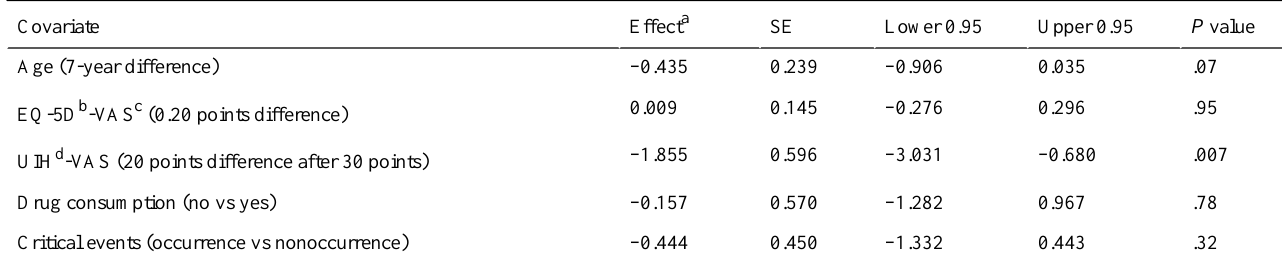
Table 3. Multivariate model for State-Trait Anxiety Inventory